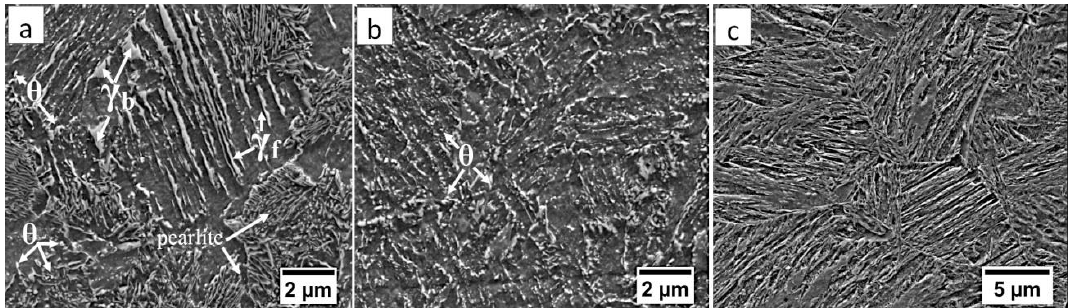
Figure 13. ( a ) The structure of the boundary between HTHAZ and LTHAZ in the area “C/D” (marked in Figure 4). Bainite with cementite precipitations (θ), blocky (γ b ), and filmy (γ f ) austenite, and pearlite. ( b ) The structure of the LTHAZ in the area “D” (marked in Figure 4). Degraded bainite with cementite precipitations (θ). ( c ) The structure of the base material in area “E” (marked in Figure 4). Degenerated upper bainite. Etched by nital SEM.